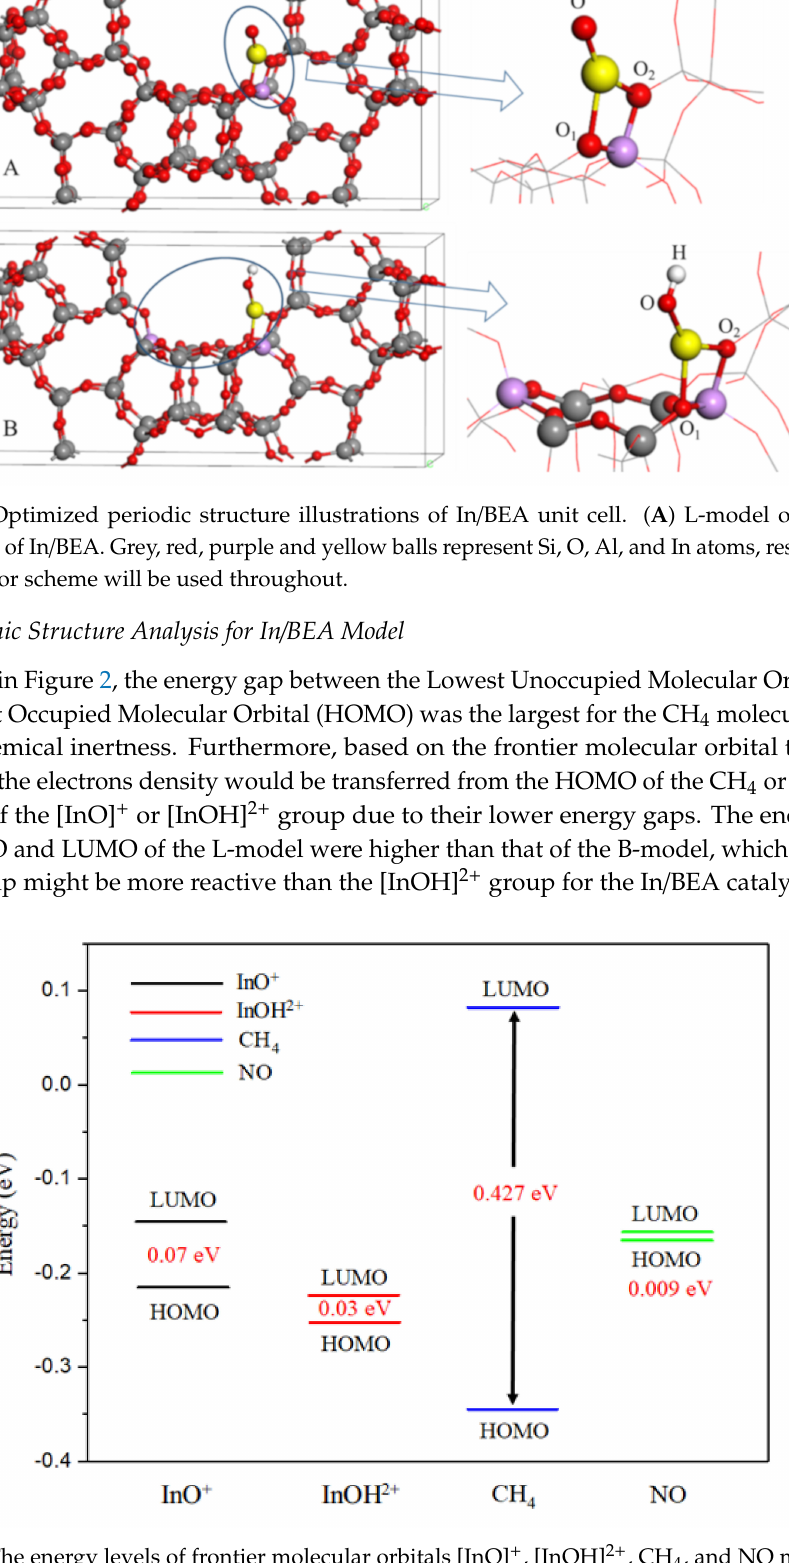
Figure 2. The energy levels of frontier molecular orbitals [InO] + , [InOH] 2 + , CH 4 , and NO